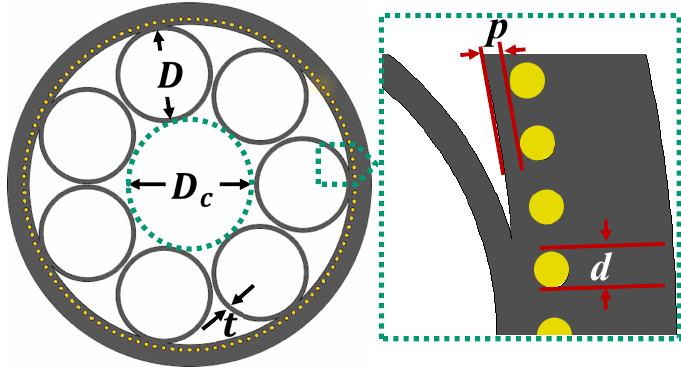
Figure 2. Schematic of metamaterial cladded AR fiber with an enlarged view of the metamaterial section. The fiber geometry has been set with seven capillary tubes of inner diameter D = 2.04 mm, strut thickness of polymer tube t = 0.09 mm, core diameter D c = 3 mm, and fiber outer diameter OD = 8.38 mm. The white, gray, and yellow colors indicate air, dielectric, and metal regions,